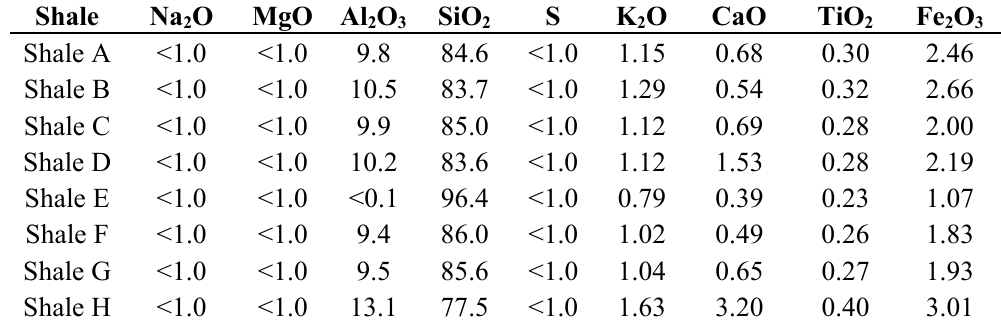
Table 3. Major element composition (wt % abundance) of the shale samples. Analyses were conducted on crushed solid fragments using X-ray fluorescence spectrometry.